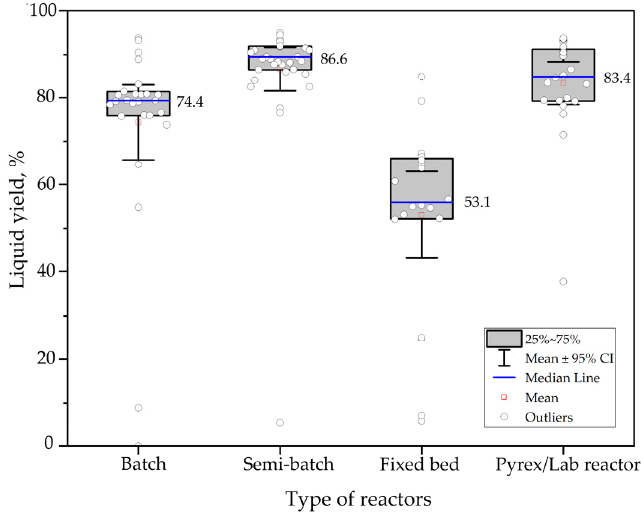
Figure 7. Influence of reactor types on liquid yield in PS thermal